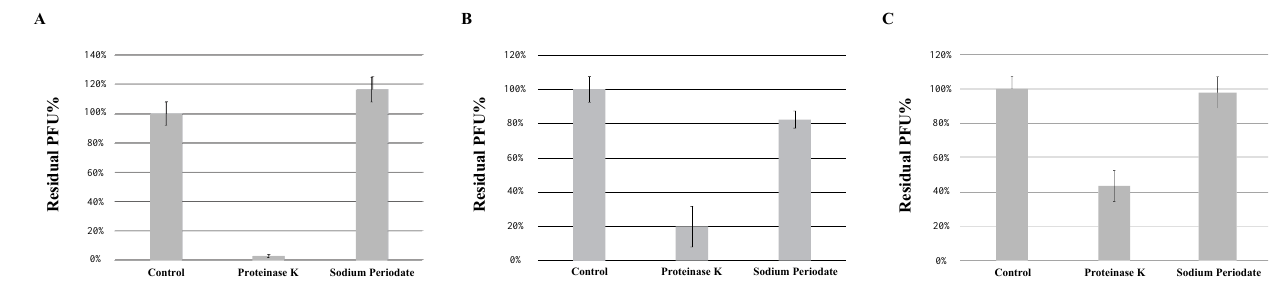
Figure 5. Effects of different treatments of bacteria on phage absorption, shown as residual PFU percentages. Effect of proteinase K treatment and sodium periodate treatment on the absorption of ( A ) KaiHaiDragon, ( B ) OneinaGillian, and ( C ) YuuY to M. foliorum . Error bars depict the standard deviations between the titers generated from three independent assays.